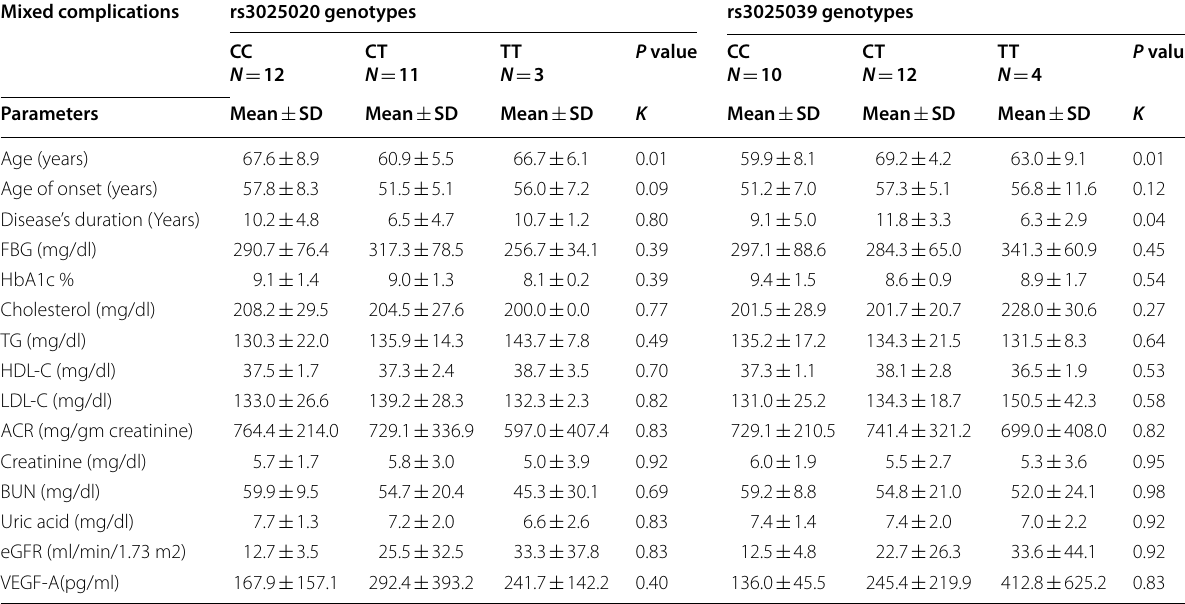
Table 4 Relationship between VEGF-A rs3025020 and rs3025039 genotypes and different studied parameters inT2DM with mixed diabetic